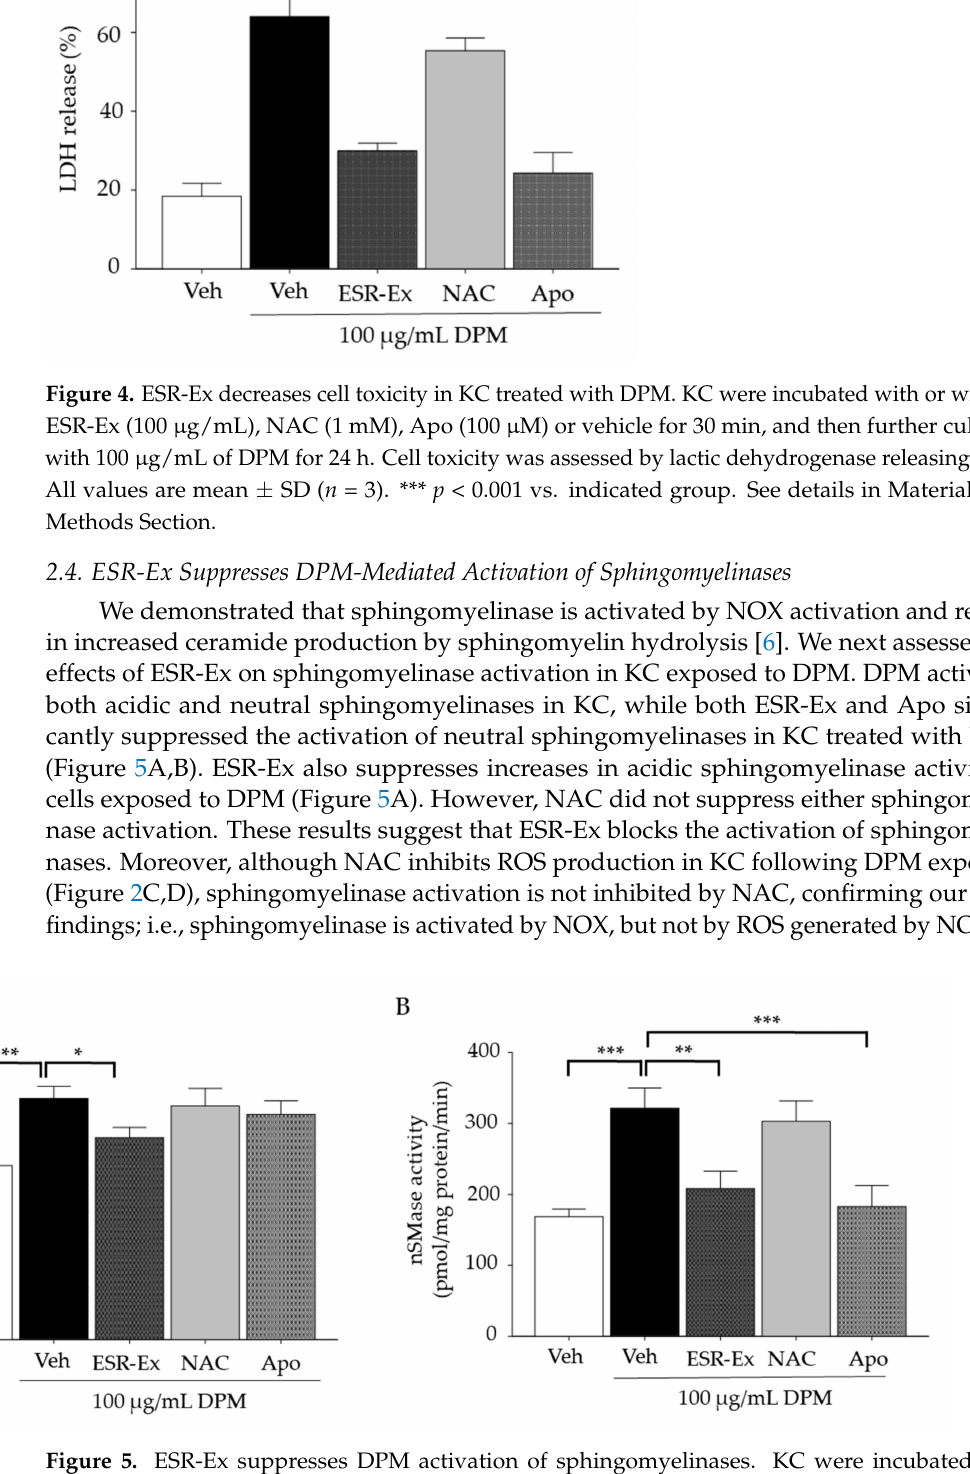
Figure 5. ESR-Ex suppresses DPM activation of sphingomyelinases. KC were incubated with or without ESR-Ex (100 µ g/mL), NAC (1 mM), Apo (100 µ M) or vehicle for 30 min, and then further cultured with 100 µ g/mL of DPM for 24 h. Activities of acidic sphingomyelinase ( A ) and neutral sphingomyelinase ( B ) were measured by LC-ESI-MS/MS. All values are mean ± SD ( n = 3). *** p < 0.001, ** p < 0.01, or * p < 0.05 vs. indicated group. See details in Materials and Methods